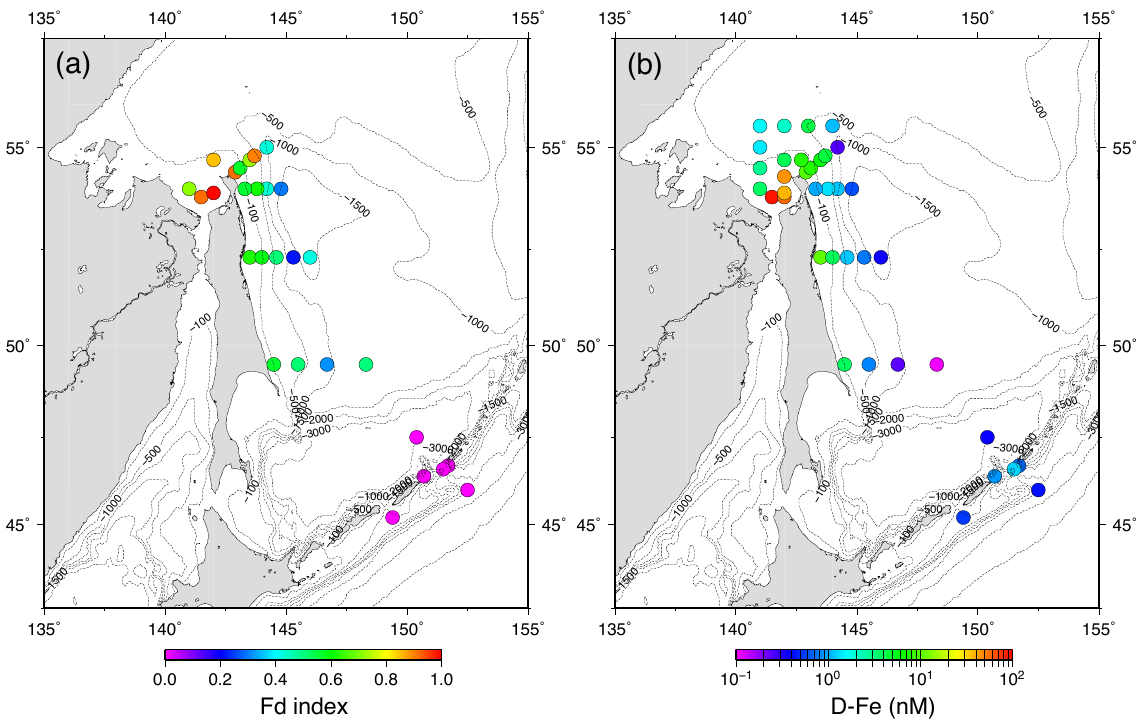
Fig. 6 ! Fig. 6. Plots of (a) the Fd index values for micro-sized diatoms and (b) dissolved iron (D-Fe) concentration (nM) in surface waters at each